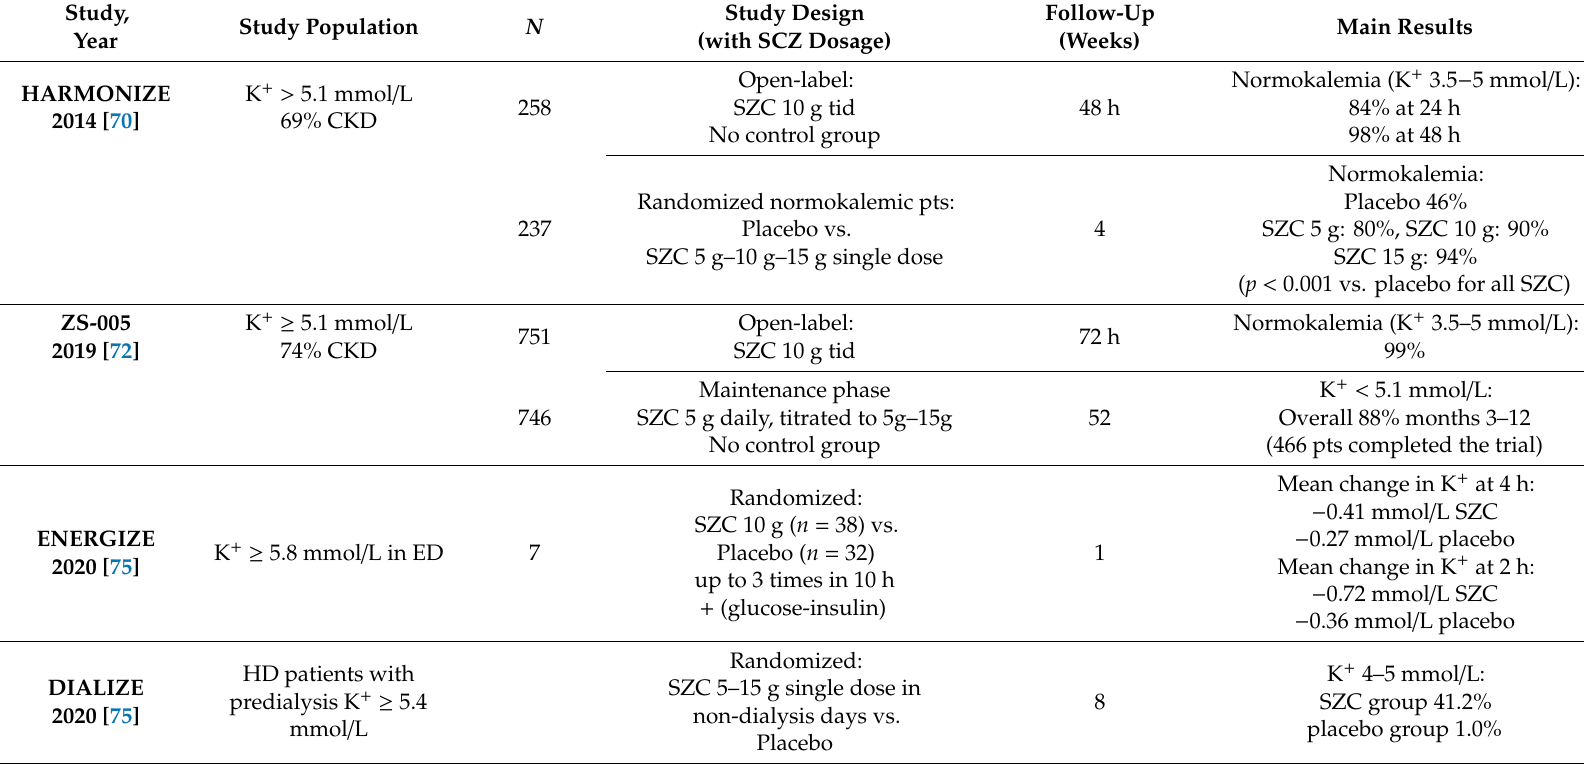
Table 2. Main clinical trials evaluating the use of sodium zirconium cyclosilicate for acute and chronic